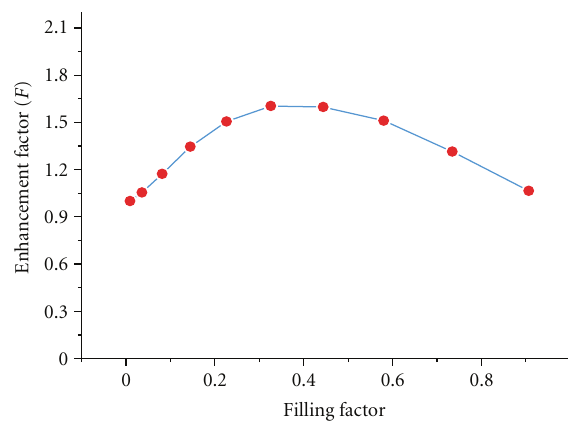
Figure 5: Enhancement of the out-coupling e ffi ciency as a function of filling